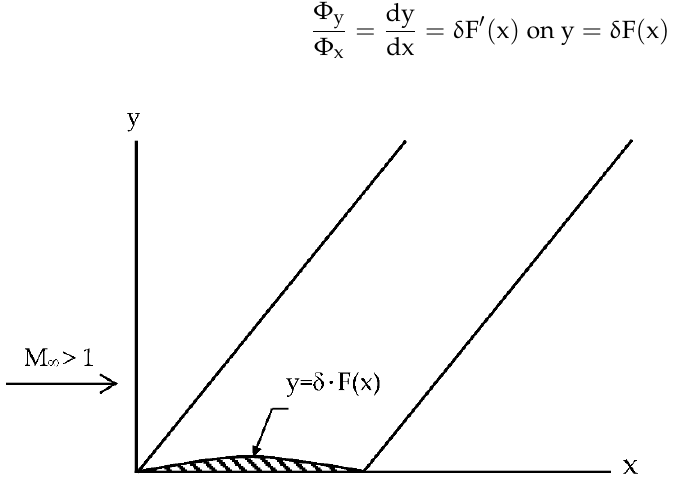
Figure 1. A 2D, inviscid, steady, isentropic compressible flow across a thin airfoil profile of y = δ F(x). F(x) value may be negative for the Prandtl–Meyer convex corner flow.